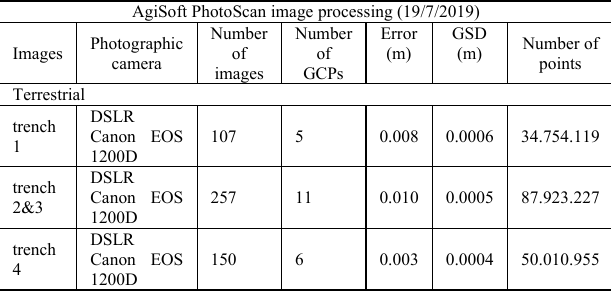
Table 4 . Number of images, GCPs and Error (m) during the Agisoft Photoscan image processing (19/7/2019).